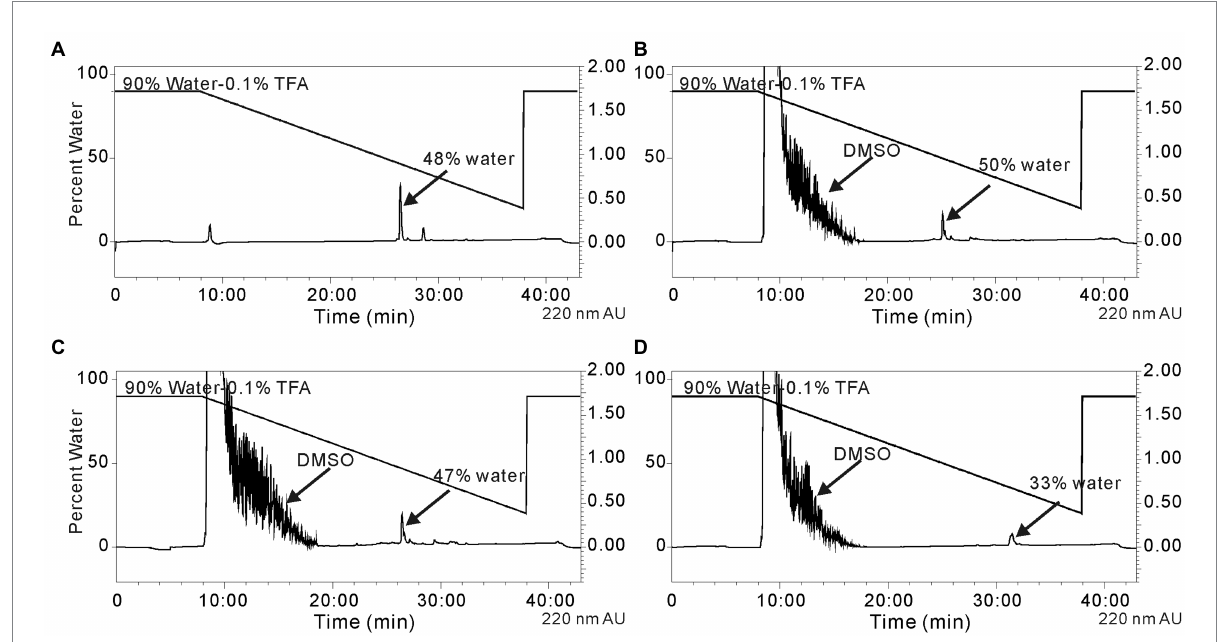
FIGURE 4 Isolation of the reductive amination products by HPLC. (A) native occidiofungin, (B) undecylamine analog following the reaction of the aldehyde analog with undecylamine, (C) dodecylamine analog following the reaction of the aldehyde analog with dodecylamine, and (D) the DL- dihydrosphingosine analog following the reaction of the aldehyde analog with d DL-dihydrosphingosine. The peak indicated by arrow is the desired product. The percentage of water at which the product being eluted from the column is labeled. Black lines represent the gradient of water with 0.1%TFA to acetonitrile. Absorbance (AU) was monitored at 220 nm. The noise in the beginning of the runs is due to DMSO in the reaction mixture.